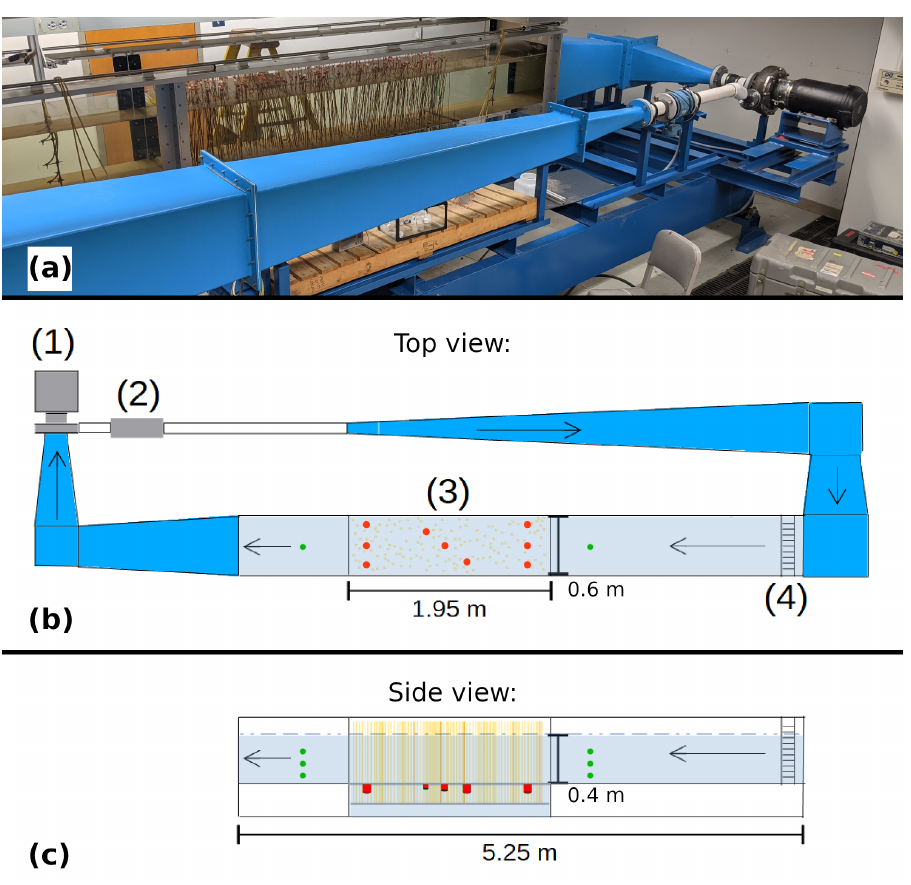
Figure 3. The Ecogeomorphology flume. Not all measurements are to scale. ( a ) Photograph of the test section (center-left) and pump (right). ( b ) Conceptual diagram of the flume as seen from above. Labeled parts are: (1) pump, (2) magnetic flowmeter, (3) test section, and (4) honeycomb flow collimator. Arrows indicate direction of flow. Green points represent the inlets for the peristaltic pumps sampling suspended particle concentration. Red circles represent the sediment traps. ( c ) A side view of the open-channel part of the system, where size differences in sediment trap symbols portray distance from the given